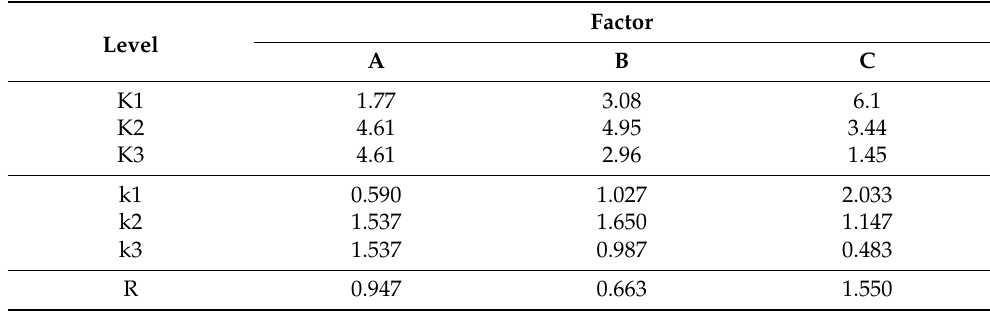
Table 2. Analysis of orthogonal test results.